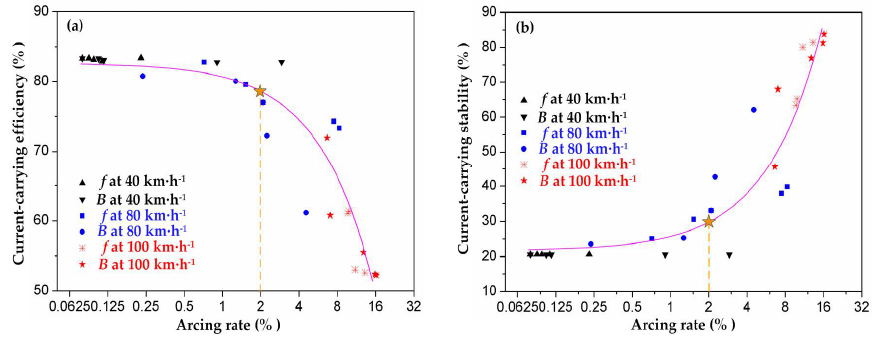
Figure 7. ( a ) Current-carrying efficiency and ( b ) current-carrying stability in decoupling experiments with the test parameters in Table 4.